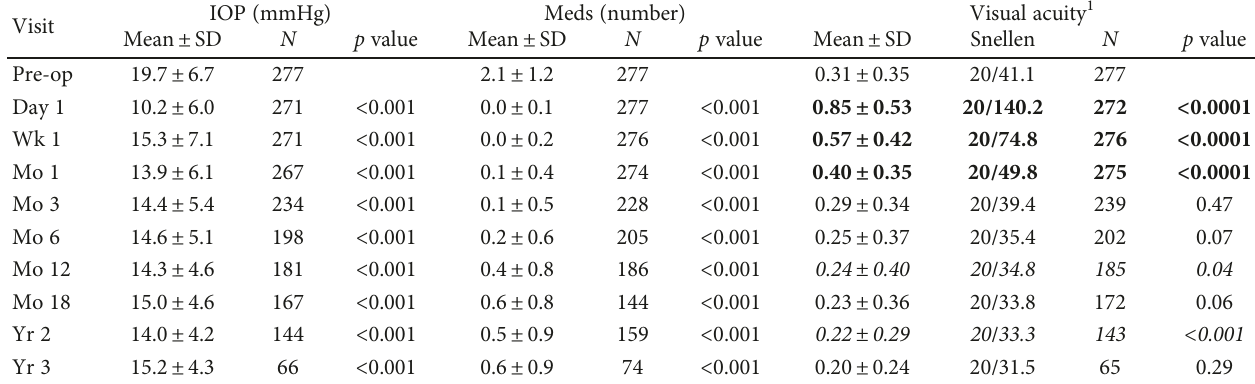
Table 2: Outcome measurements by visit (all eyes).